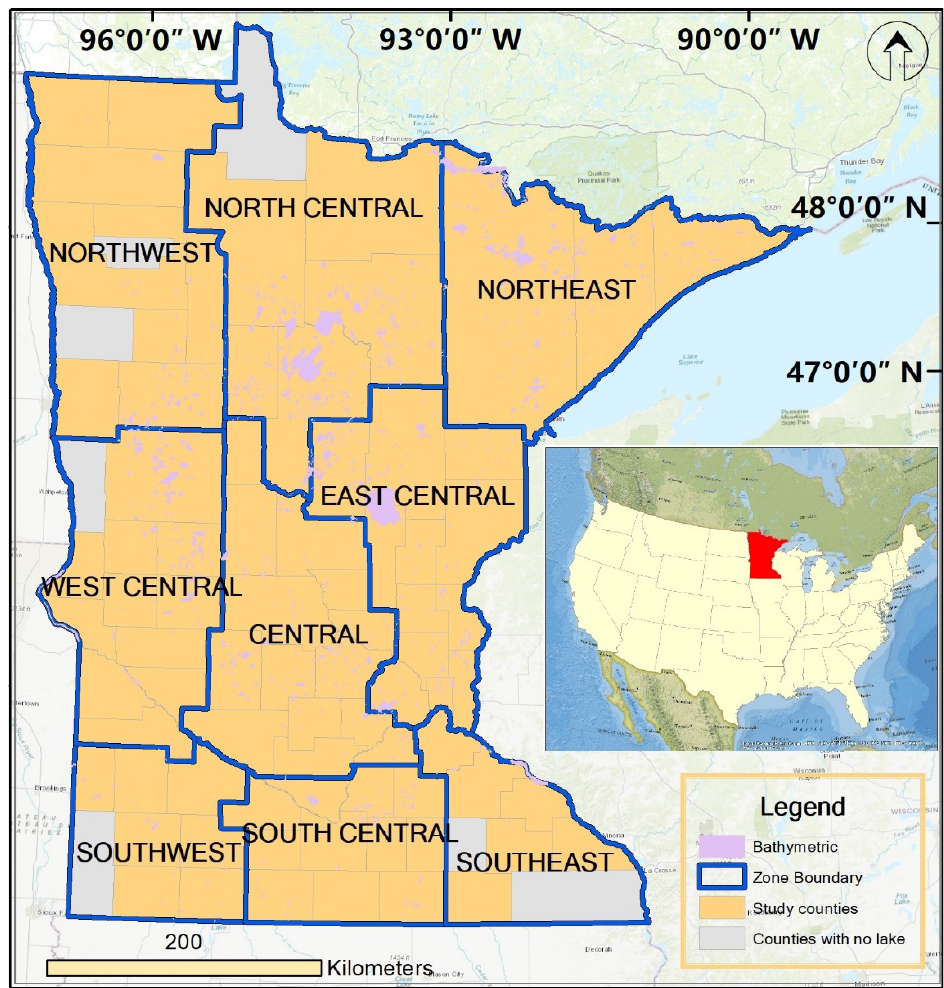
Figure 2. Our study area with lake bathymetric data in the state of Minnesota.